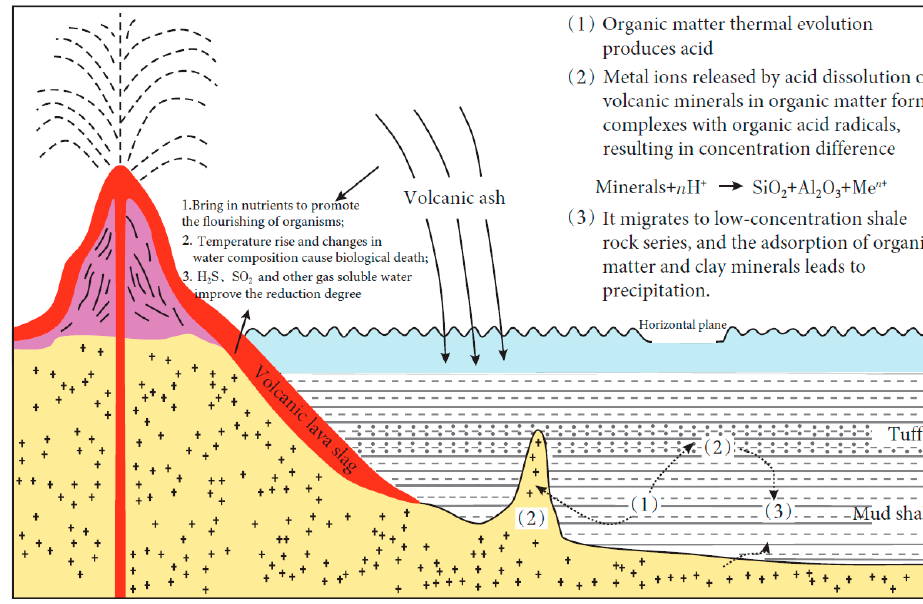
Figure 4. In fl uence model of volcanic activity on sedimentary basins (Ref. [85]) . Figure 4. Influence model of volcanic activity on sedimentary basins (Ref.